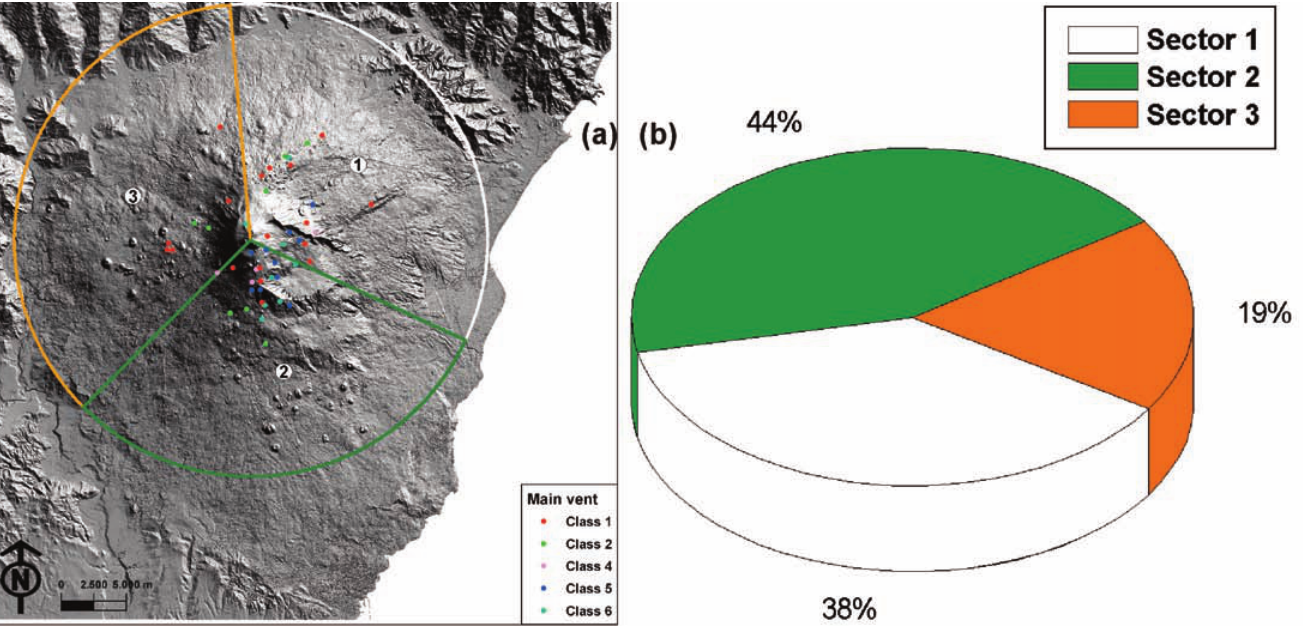
Figure 6. a) Subdivisions of the Etna volcano edifice into three sectors, and classification of the main vents on the basis of the six eruptive classes. b) Pie diagram showing the percentages of the vents located in each